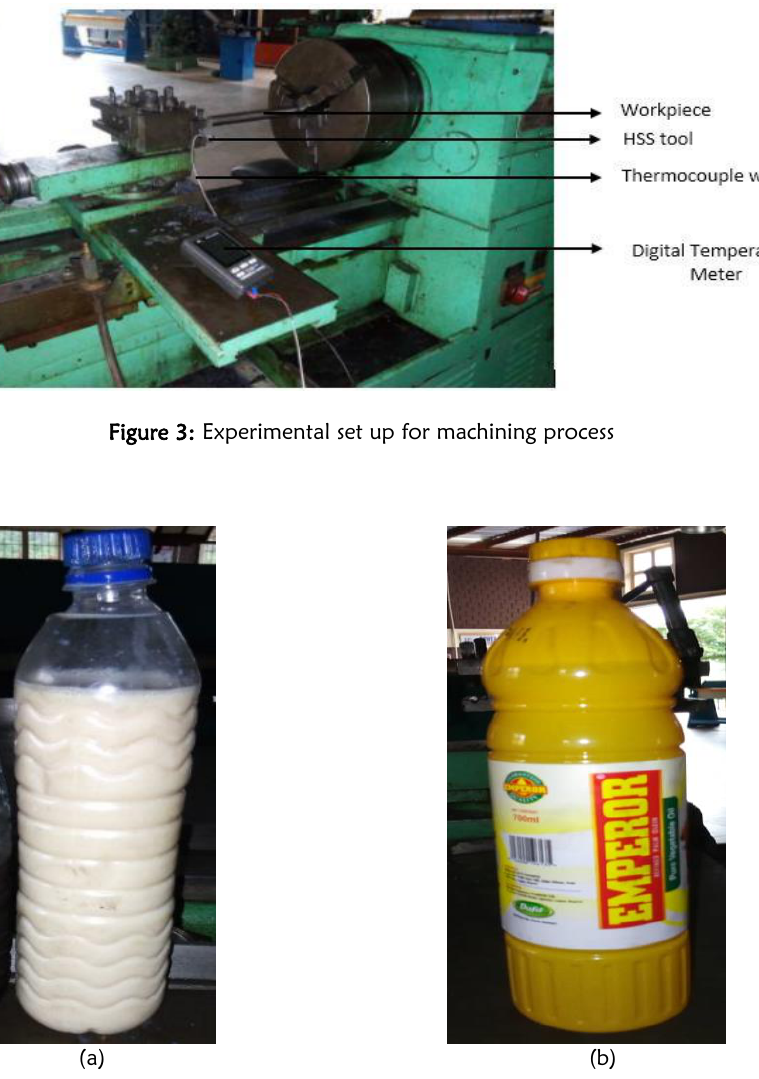
Figure 4: Cutting fluids used for experimentation (a) Soluble Oil, (b) Vegetable